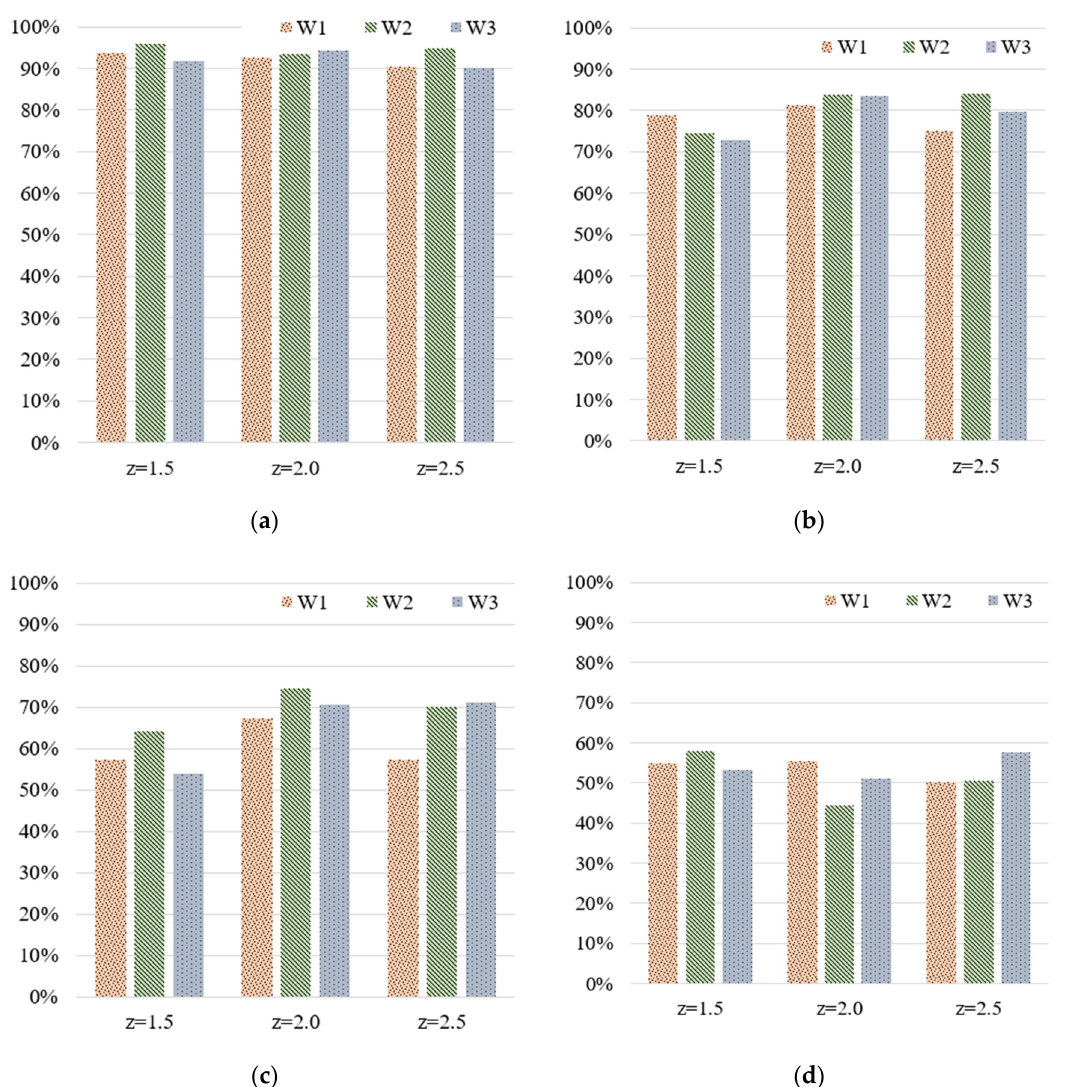
Figure 6. Training accuracy for the widths of the integrated circuit (IC) tray with respect to various z-scores and numbers of grades: ( a ) 5, ( b ) 10, ( c ) 20, and ( d ) 50 grades. Table 6. Average training accuracy versus z-score and number of grades. Grade